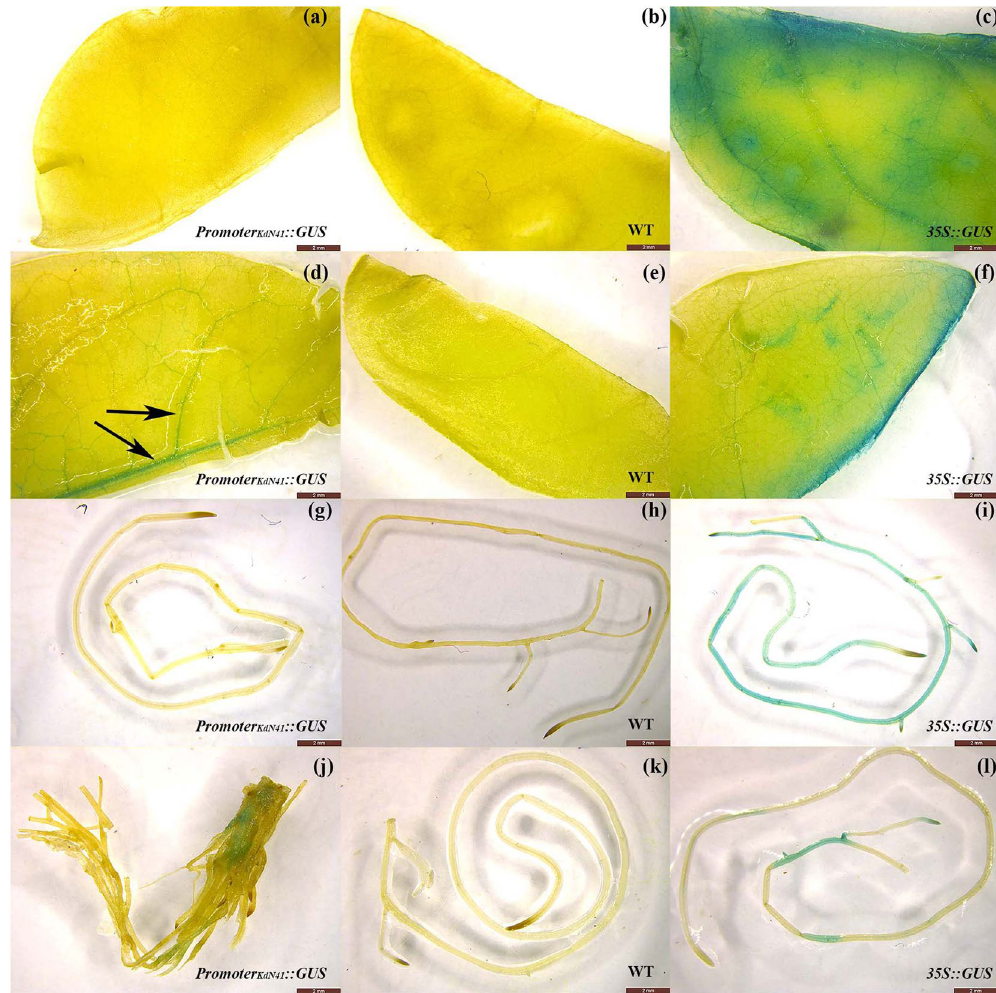
Figure 3. KdN41 GUS staining analyses of Promoter KdN41 ::GUS , wild type (WT), and 35 S::GUS (PC) tobacco plants after drought stress using 20% PEG. ( a – c ) leaf staining results with no drought treatment; ( d – f ) leaf staining results under drought treatment; ( g – i ) root staining results with no drought treatment; ( j – l ) root staining results under drought treatment; Black arrows mark GUS staining area in leaf vein of Promoter KdN41 ::GUS